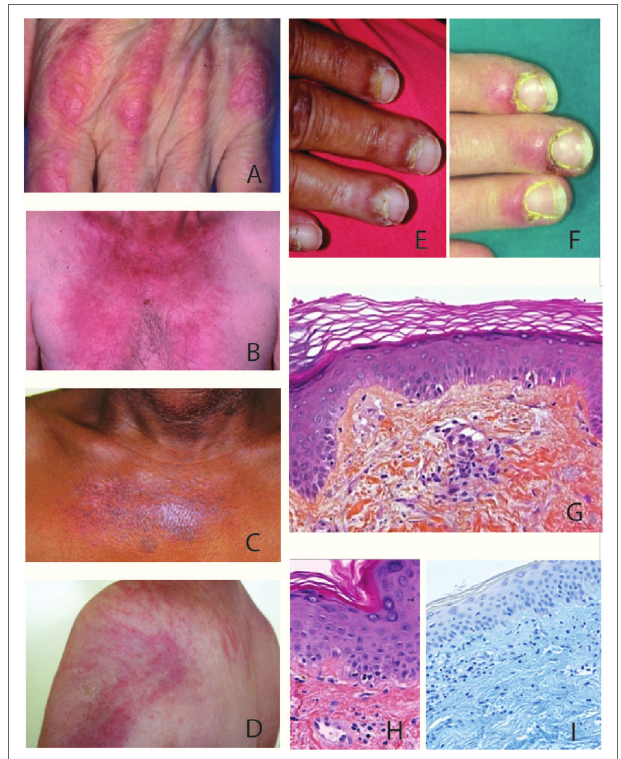
FigURe 1 | Clinical and histological features of dermatomyositis (DM). (A) Gottron’s sign: erythematous scaly papules over the metacarpophalangeal joints. (B) «V sign» in a white European male patient with DM. (C) Poikiloderma (i.e., erythema, atrophy, variable pigmentary changes) on the upper trunk of an African Caribbean female patient with DM. (D) Typical centripetal flagellate erythema affecting the upper trunk of a male patient with DM. (e,F) Periungual erythema and telangiectatic capillary loops in patients with DM. (g–i) Histological feature of a Gottron’s papule. (g) Slight hyperkeratosis, basal cell vacuolar degeneration, upper dermal edema, and perivascular inflammatory cell infiltrate with enlarged capillaries (HES staining, × 20). (H) DM interface dermatitis with vacuolar changes of the basal cell layer, perivascular inflammatory cell infiltrate with capillary dilatation, endothelial cell turgescence, and pigmentary incontinence (HES staining, × 40). (i) Positive alcian-blue staining attesting dermal mucin deposits ( ×